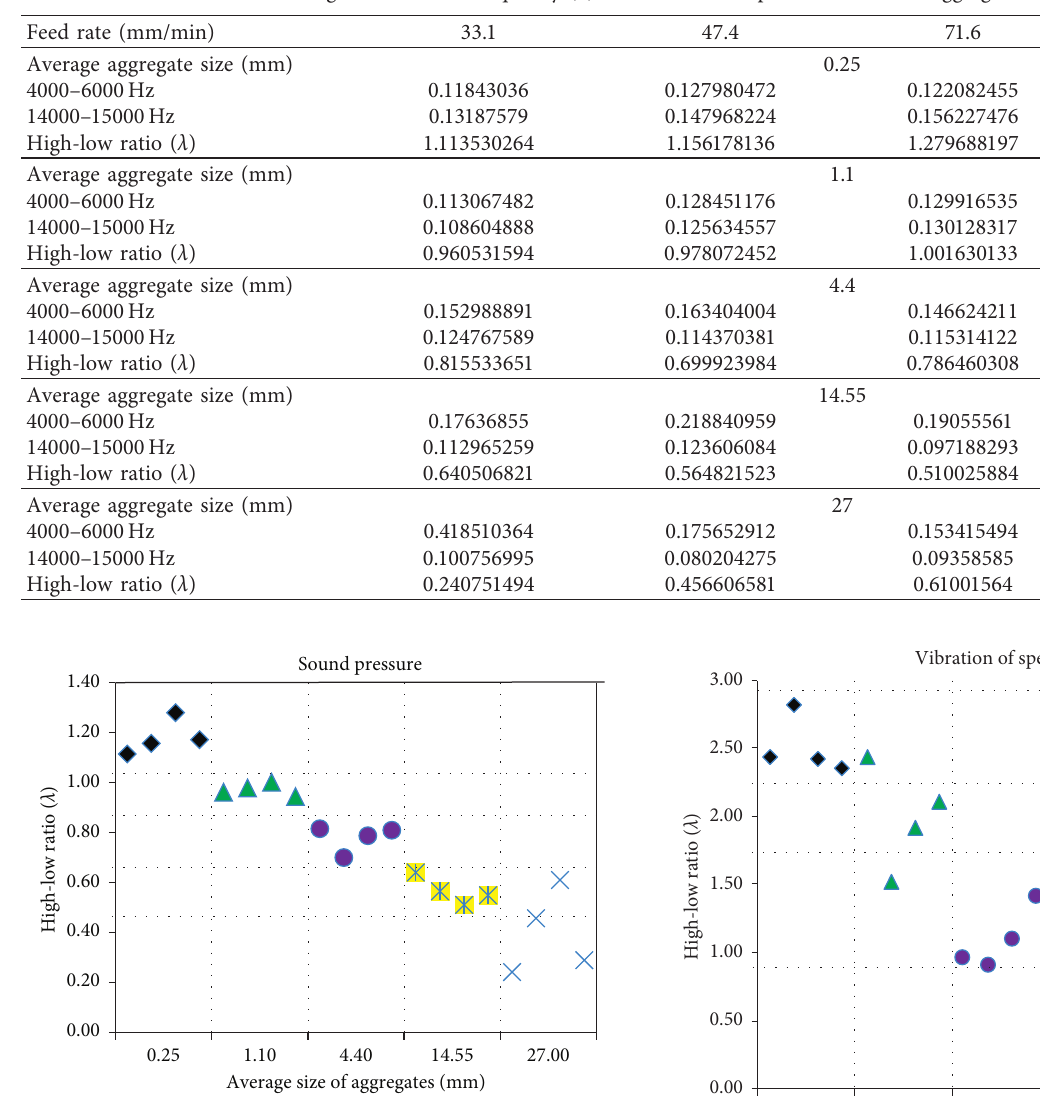
Figure 9: High-low ratio of sound frequency vs. aggregate size.